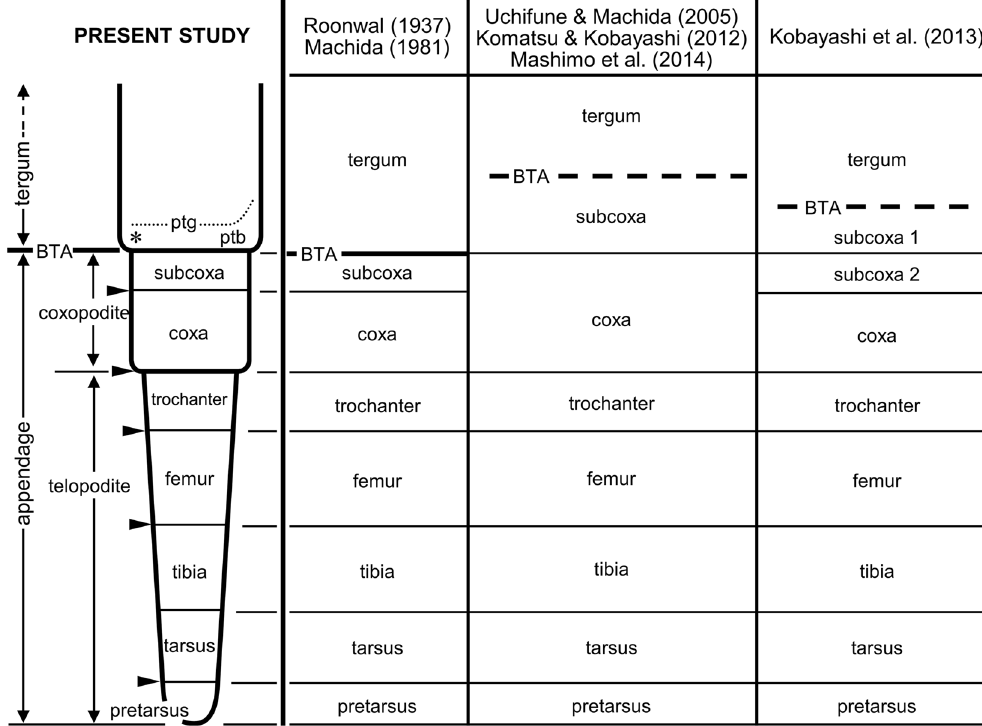
Figure 1. Segmentation of appendage with special reference to identification of the proximal podomeres and the boundary between the tergum and the appendage: conclusions from this embryological study on Gryllus bimaculatus and comparisons with previous studies. Abbreviations: BTA, boundary between tergum and appendage; ptb, paratergal bulge; ptg, paratergal groove. Asterisk and arrowheads show the spiracle and domains of Tc-ser expression in Coulcher et al . 4 ,